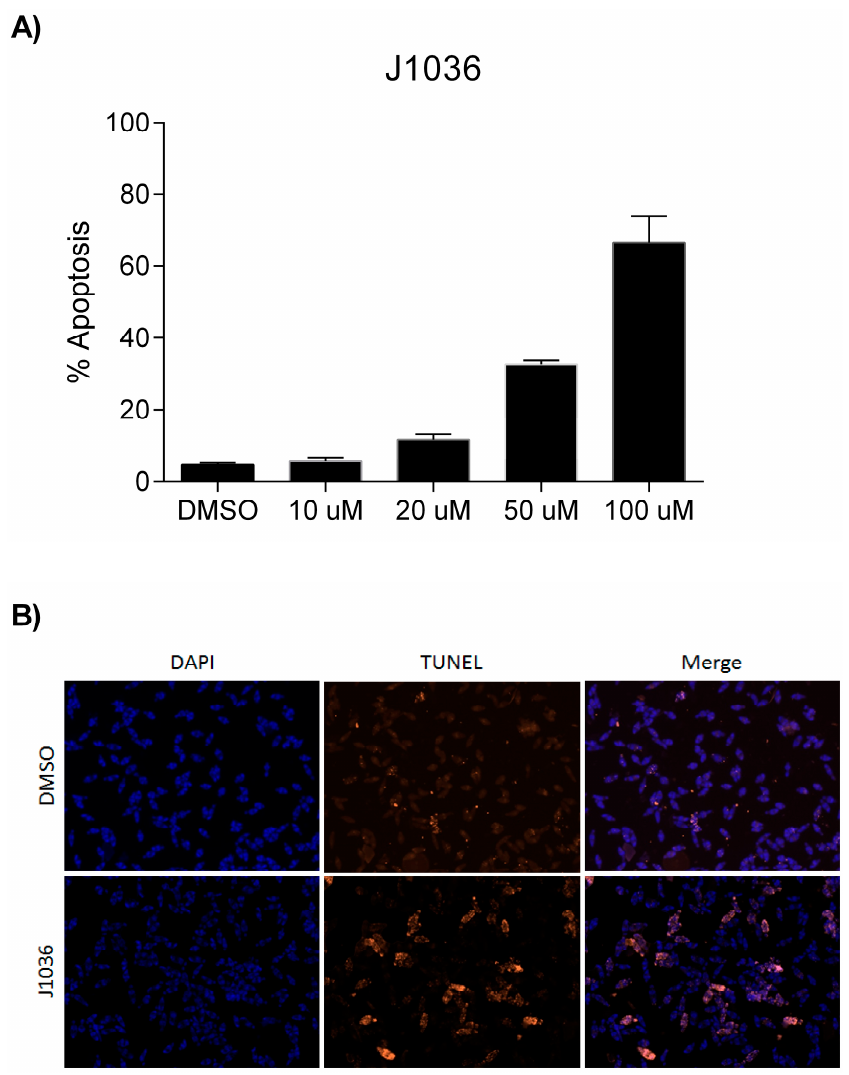
Figure 4. J1036 induces apoptosis in S. mansoni schistosomula in vitro. ( A ) Dose-dependent induction of apoptosis determined by dUTP nick end labeling (TUNEL) shown as the percentage of parasites positively labeled; ( B ) TUNEL staining of schistosomula treated with 100 µM J1036 for 3 days. Parasites were counterstained using 4 ′ ,6-Diamidino-2-Phenylindole (DAPI).